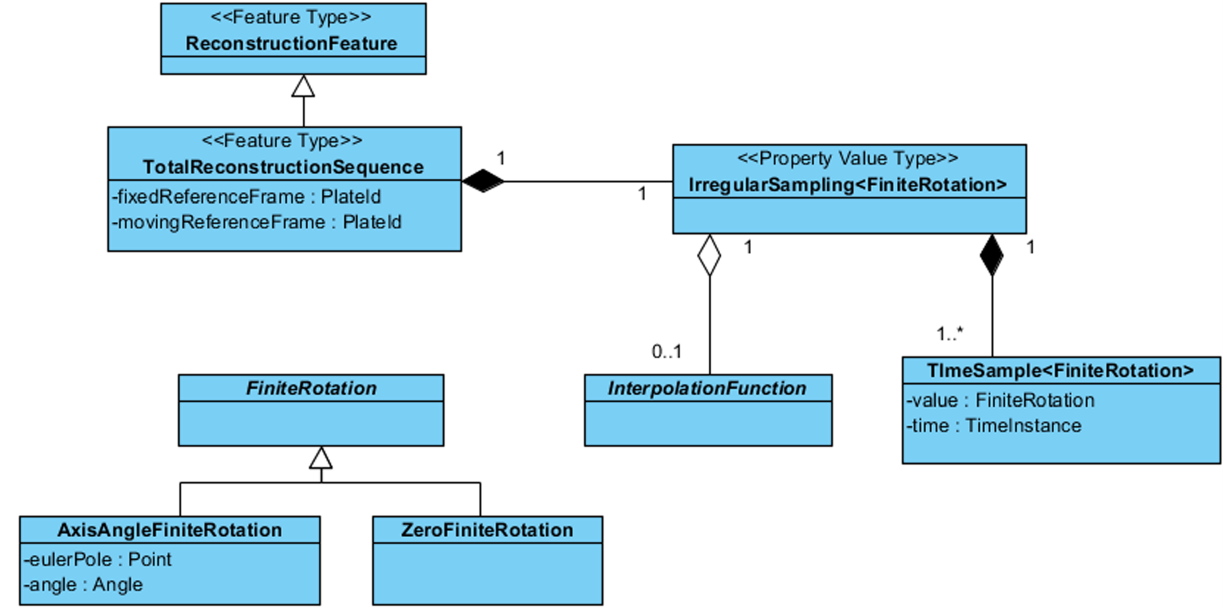
Fig. 2. UML diagram of ReconstructionFeature and